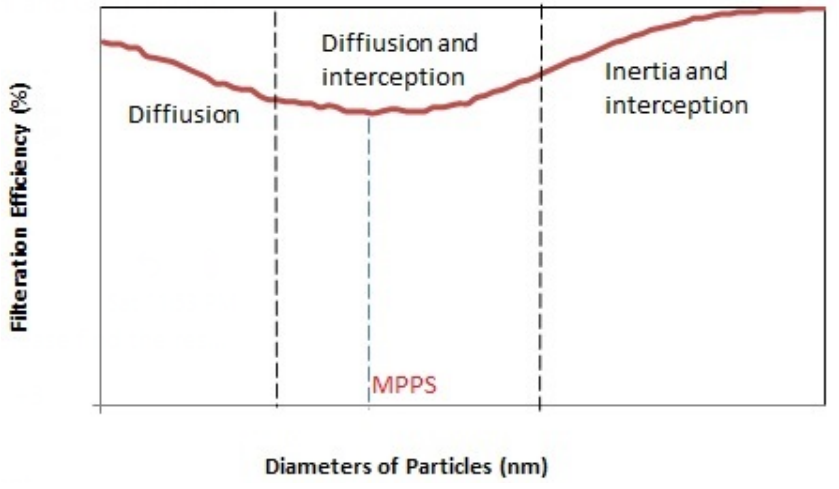
Figure 6. The efficiency of filter vs. particle diameter in the diffusion and interception regime.